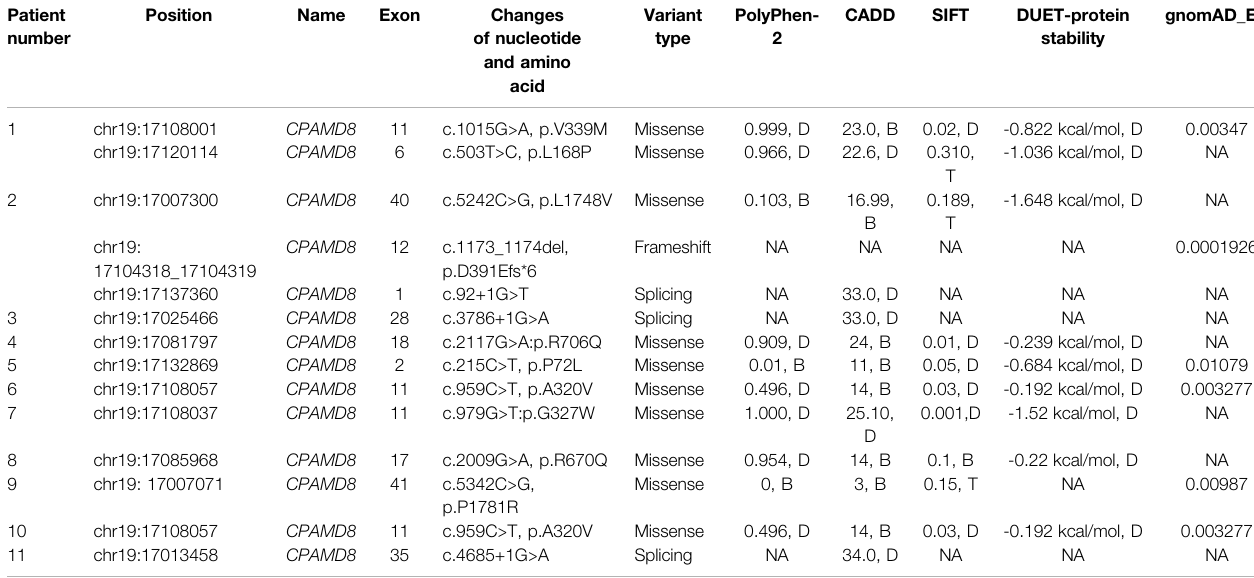
TABLE 4 | Summary of sporadic PG patients with CPAMD8